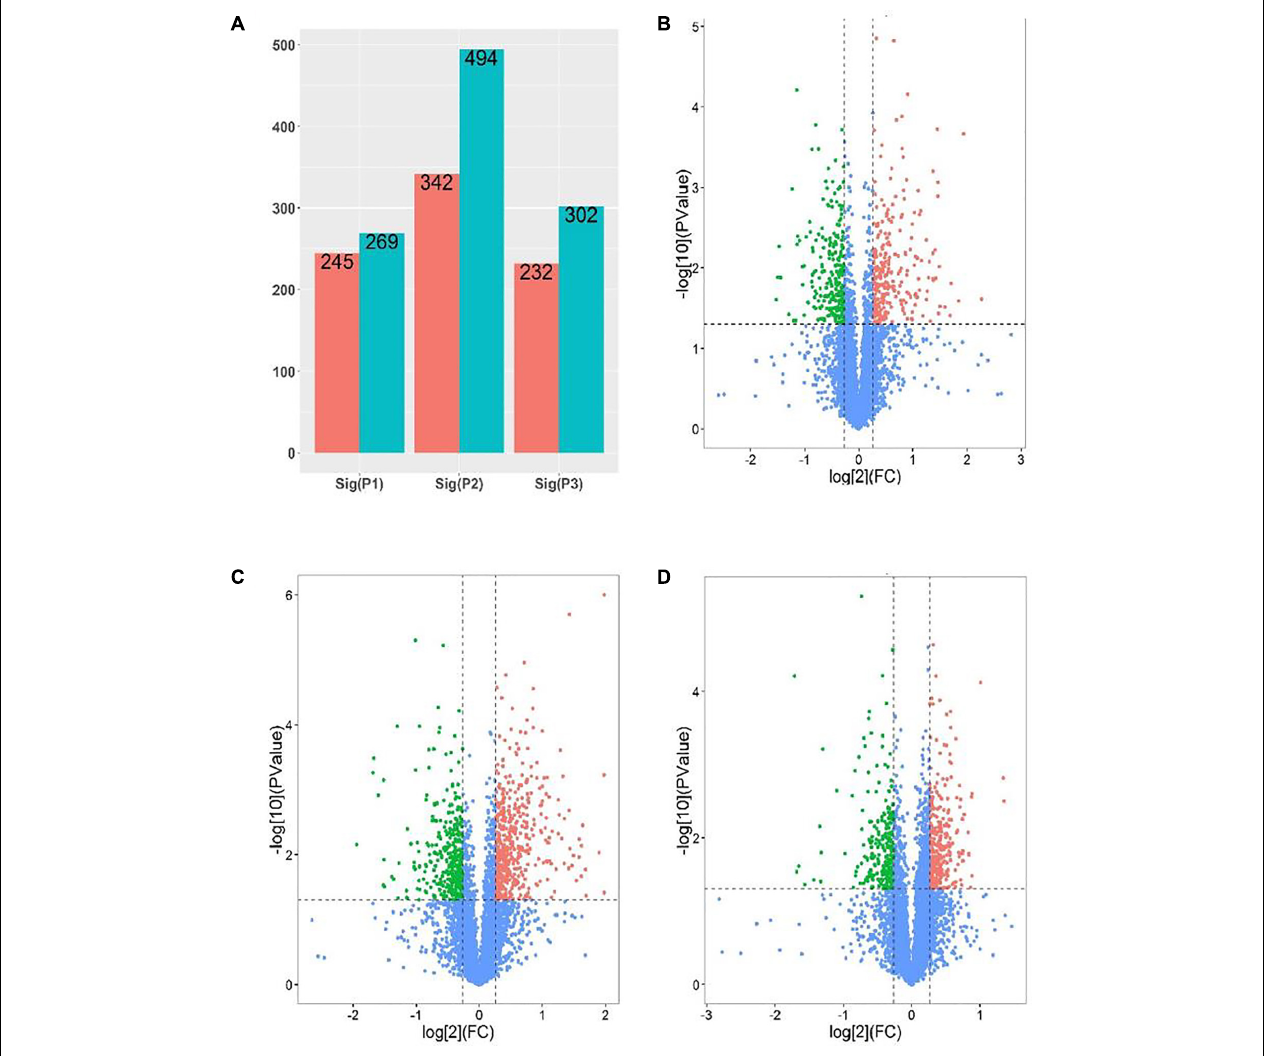
FIGURE 6 | Analysis of DEPs [P1 and panel (B) : low salinity/control; P2 and panel (C) : high salinity/control; P3 and panel (D) : high salinity/low salinity]. (A) The number of upregulated (Blue) and downregulated (red) proteins in different comparison groups. (B–D) Volcano maps representing expression patterns of DEPs recorded in different comparison groups. Each point represents the difference in protein expression (fold-change) between the two groups plotted against the level of statistical significance. Here, red spots represent upregulated DEGs, while green spots indicate downregulated proteins. Those shown in blue are proteins that did not show obvious changes in compared